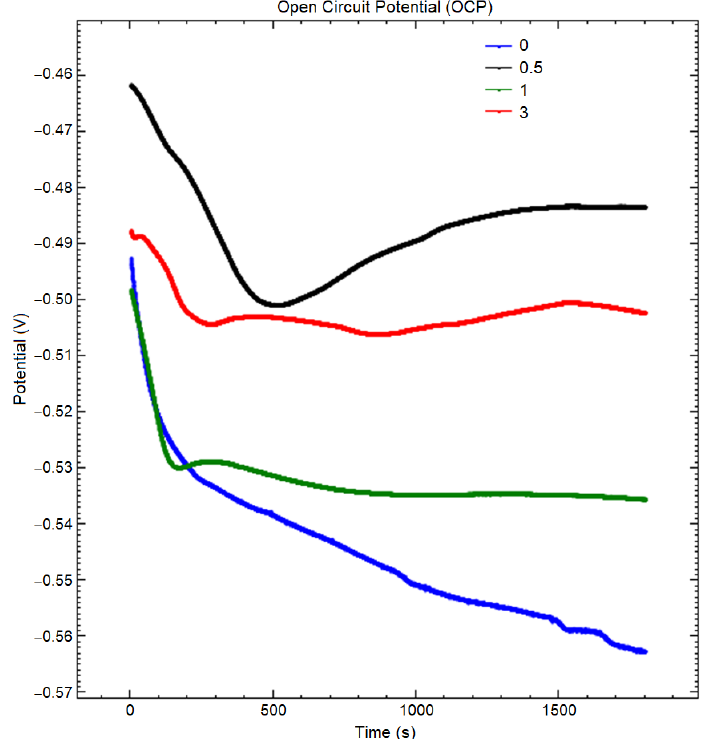
Figure 2. Open circuit potential with increasing time of Ni-W alloy and Ni-W/B (boron concentrations of 0, 0.5, 1, and 3 g/L) composite coatings immersed in 3.5 wt.% NaCl solution.